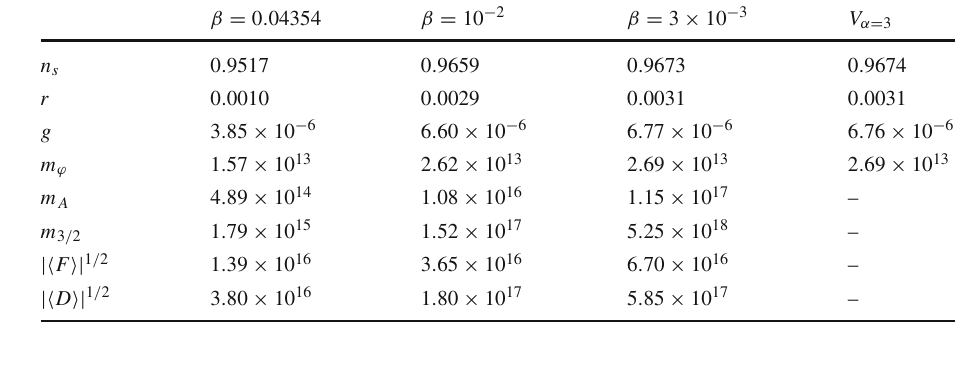
observables, relevant masses, and SUSY breaking parameters for α = 3 and negative β . The parameters m ϕ , m A , m 3 / 2 , |(cid:7) F (cid:8)| 1 / 2 , and |(cid:7) D (cid:8)| 1 / 2 are